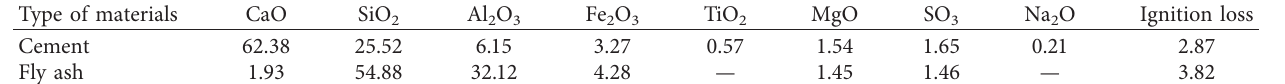
Table 1: Chemical composition of cement and mineral admixtures (mass fraction, %).